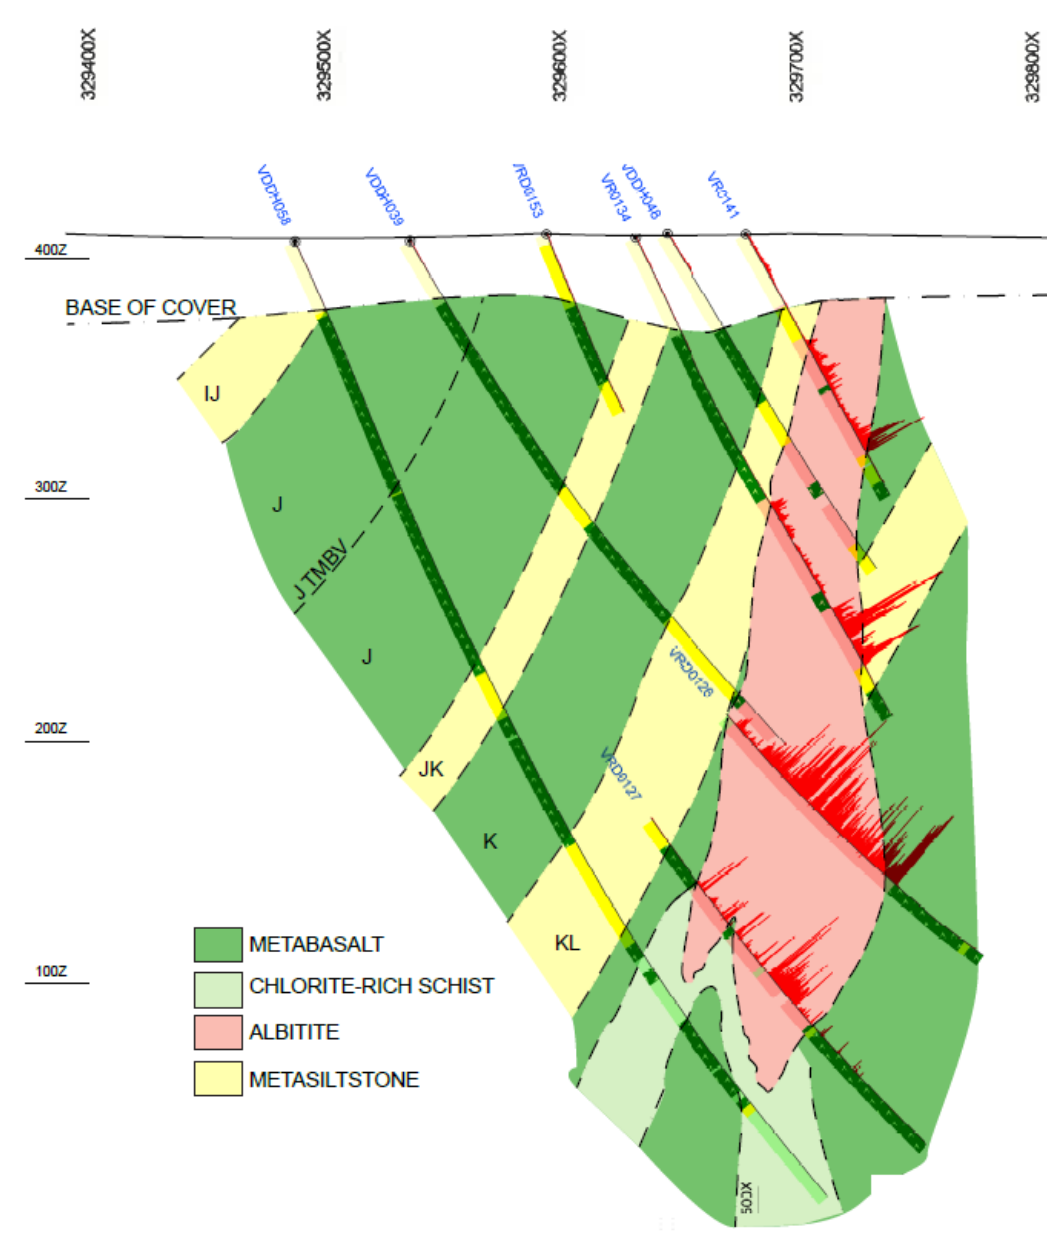
Figure 2. Cross-section 7744850 mN, Valhalla deposit. The red bars on drillhole traces represent the tenor of uranium